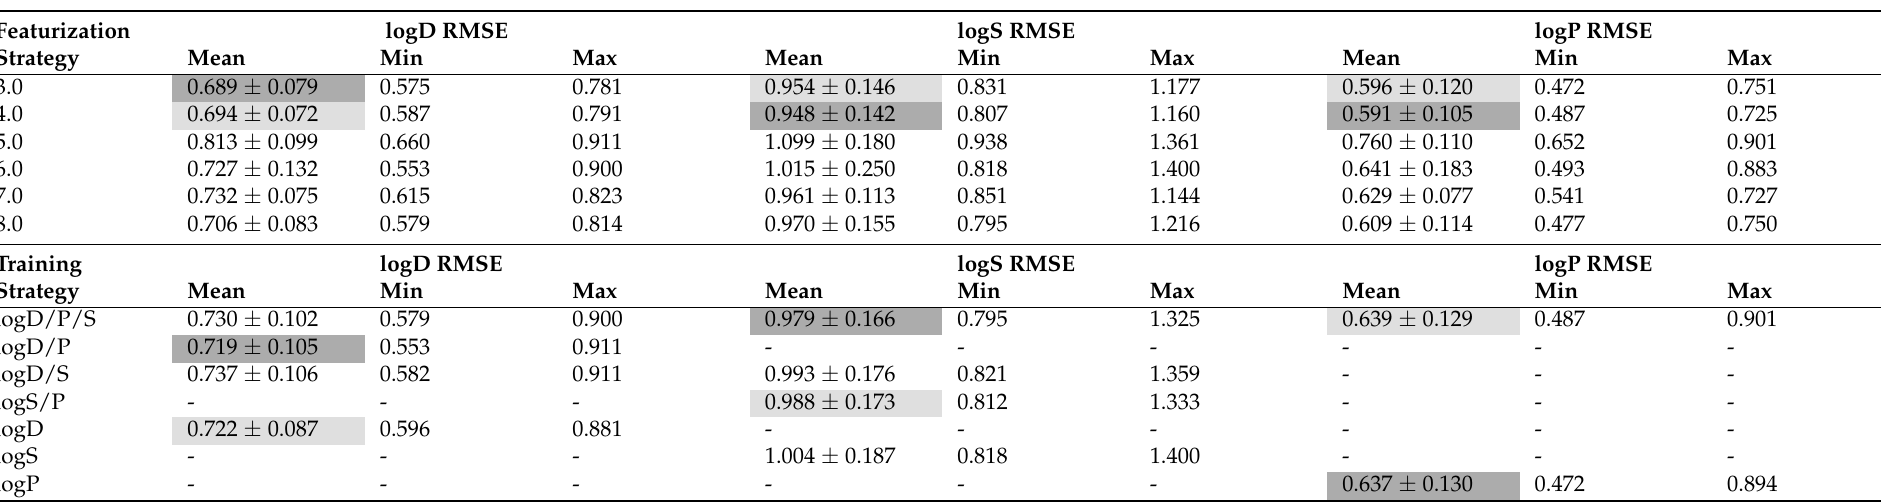
Table 3. Impact of the featurization and training strategy on the different molecular properties independent of what GNN model type was used. For each endpoint the mean, minimum, and maximum RMSE can be seen. The dark gray boxes show the best RMSE for the particular property, the light gray the second